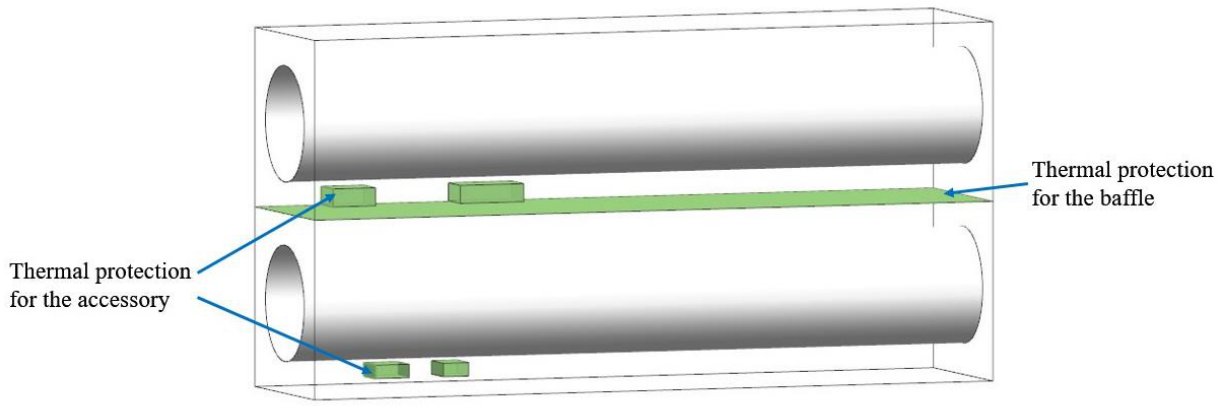
Figure 20. The diagram of the combined thermal protection for the casing and accessory.